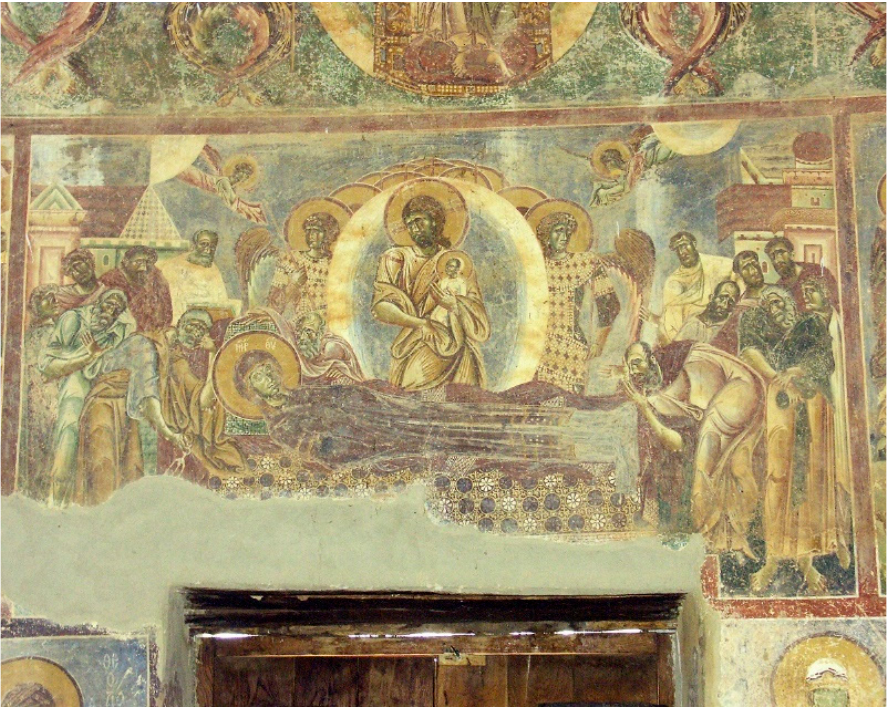
Figure 1. Dormition of the Theotokos , wall painting, ca. 1190, Church of St. George, Kurbinovo, Republic of North Macedonia. (Photo credit: Pravoslavnyy Svyato-Tikhonovskiy Gumanitarnyy Universitet ).